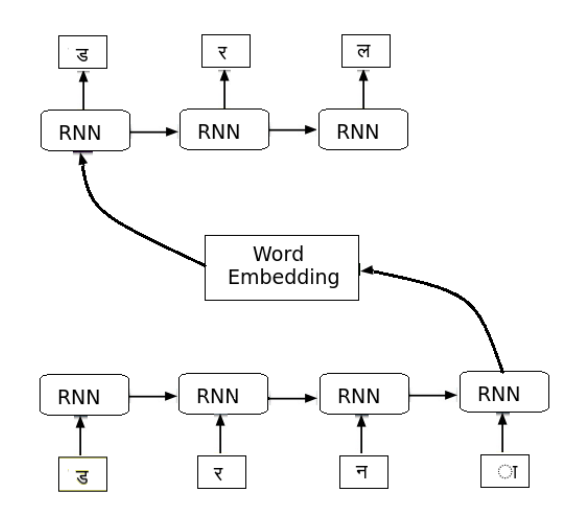
Figure 1: Encoder-decoder network architecture transducing the Hindi word डरना [darnA] (to be